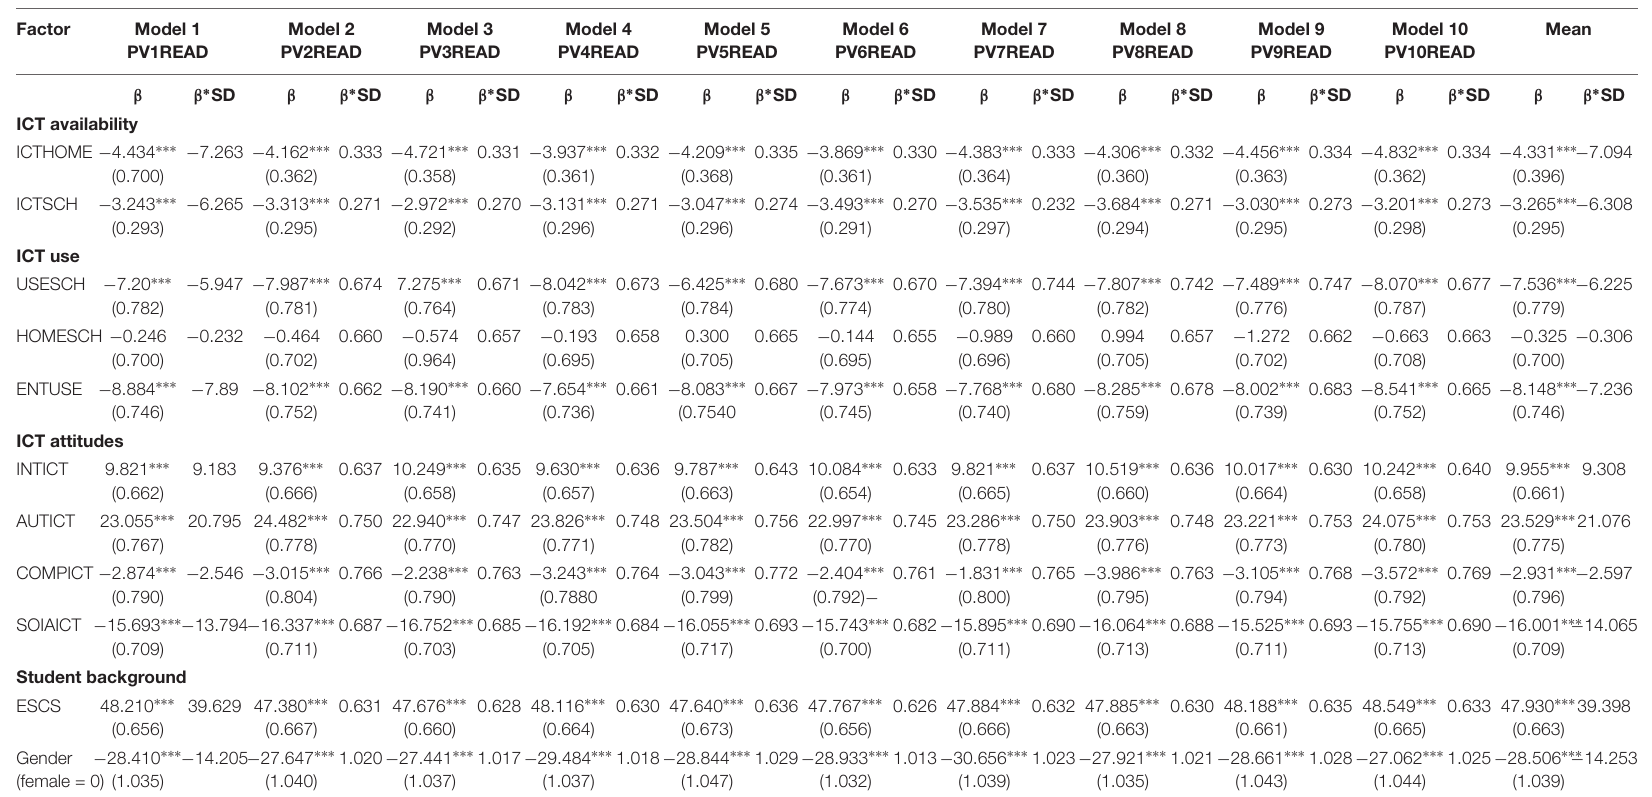
TABLE 5 | The effect of ICT impact factors on reading